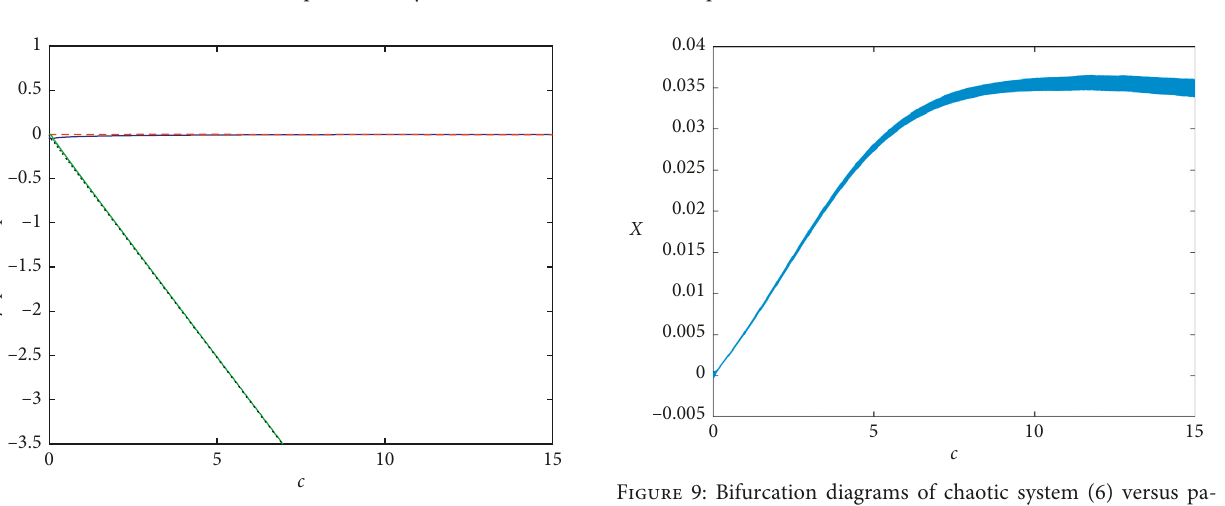
Figure 7: Phase portrait of system (6) with different circuit parameters (a) a